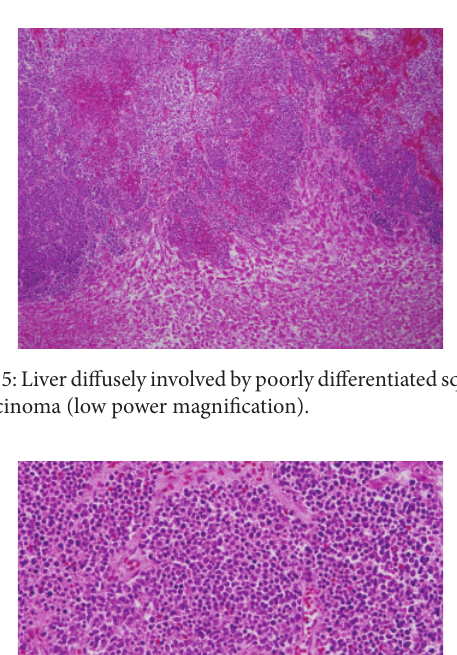
Figure 4: Cut section of liver with diffuse showed involvement by numerous tumor masses and nodules replacing most of the liver parenchyma.